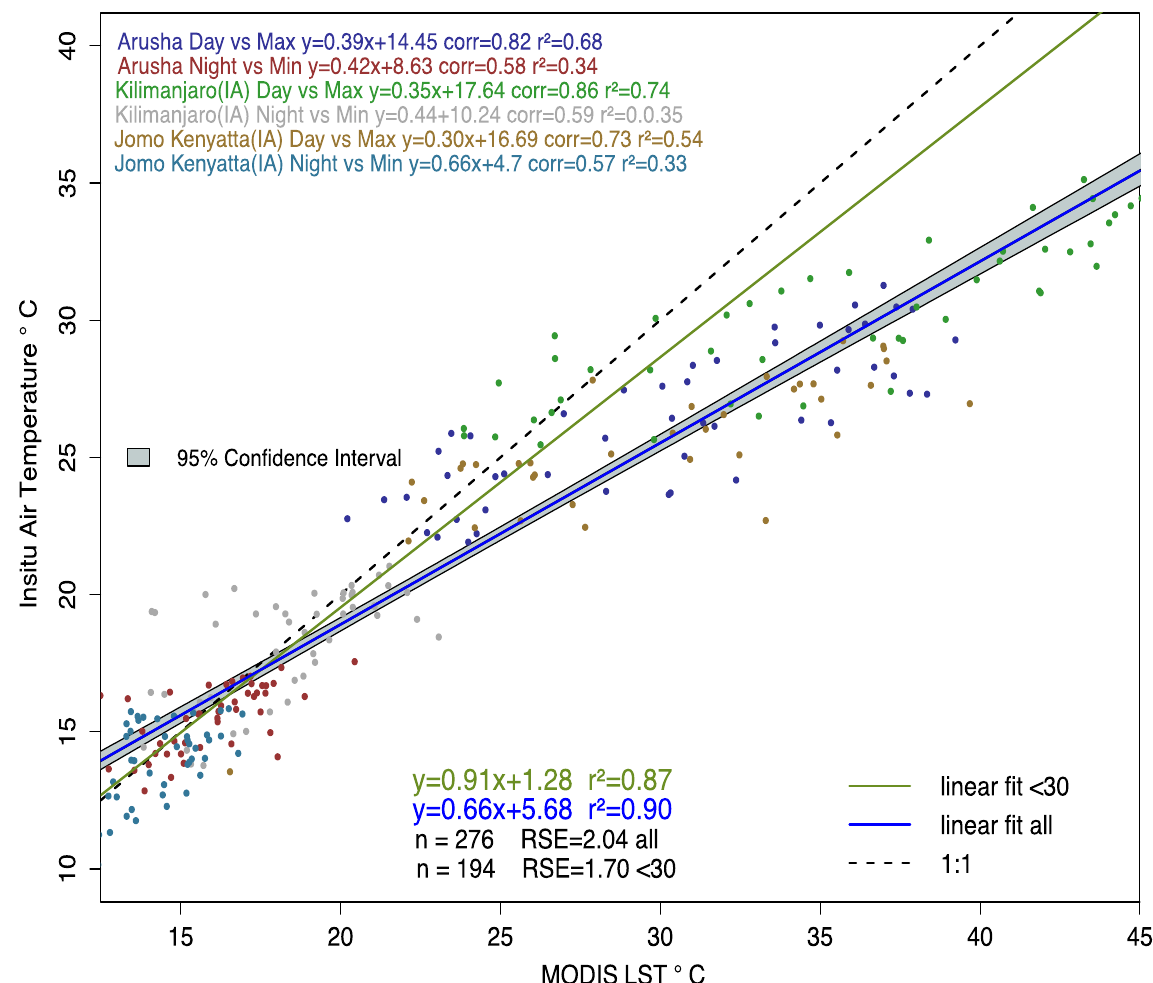
Figure 5. Comparison of MODIS day and night LST and minimum and maximum in situ air temperature over three stations in East Africa for all temperature values, and values below 30 °C, RSE stands for regression standard